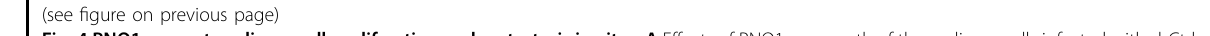
Fig. 4 PNO1 promotes glioma cell proliferation and metastasis in vitro. A Effects of PNO1 on growth of three glioma cells infected with shCtrl or shPNO1. n = 3, **P < 0.01. B Effects of PNO1 on cell apoptosis of three glioma cells infected with shCtrl or shPNO1. n = 3, **P < 0.01. C Plate clone formation assay was used to detect PNO1 effect on three glioma cell lines infected with shCtrl, shPNO1, or PNO1. n = 3, **P < 0.01, *** P < 0.001. D CCK8 assays showing cell growth in three glioma cell lines infected with shCtrl, shPNO1, or PNO1. n = 3, **P < 0.01, *** P < 0.001. E Transwell assays were used to detect invasive ability of three glioma cell lines infected with shCtrl, shPNO1, or PNO1. n = 3, ***P < 0.001. ( F and G ) Western Blotting ( C ) and RT-PCR ( D ) showing PNO1 protein and mRNA levels in three glioma cell lines infected with shCtrl, shPNO1, or PNO1(PNO1 overexpression). n = 3,